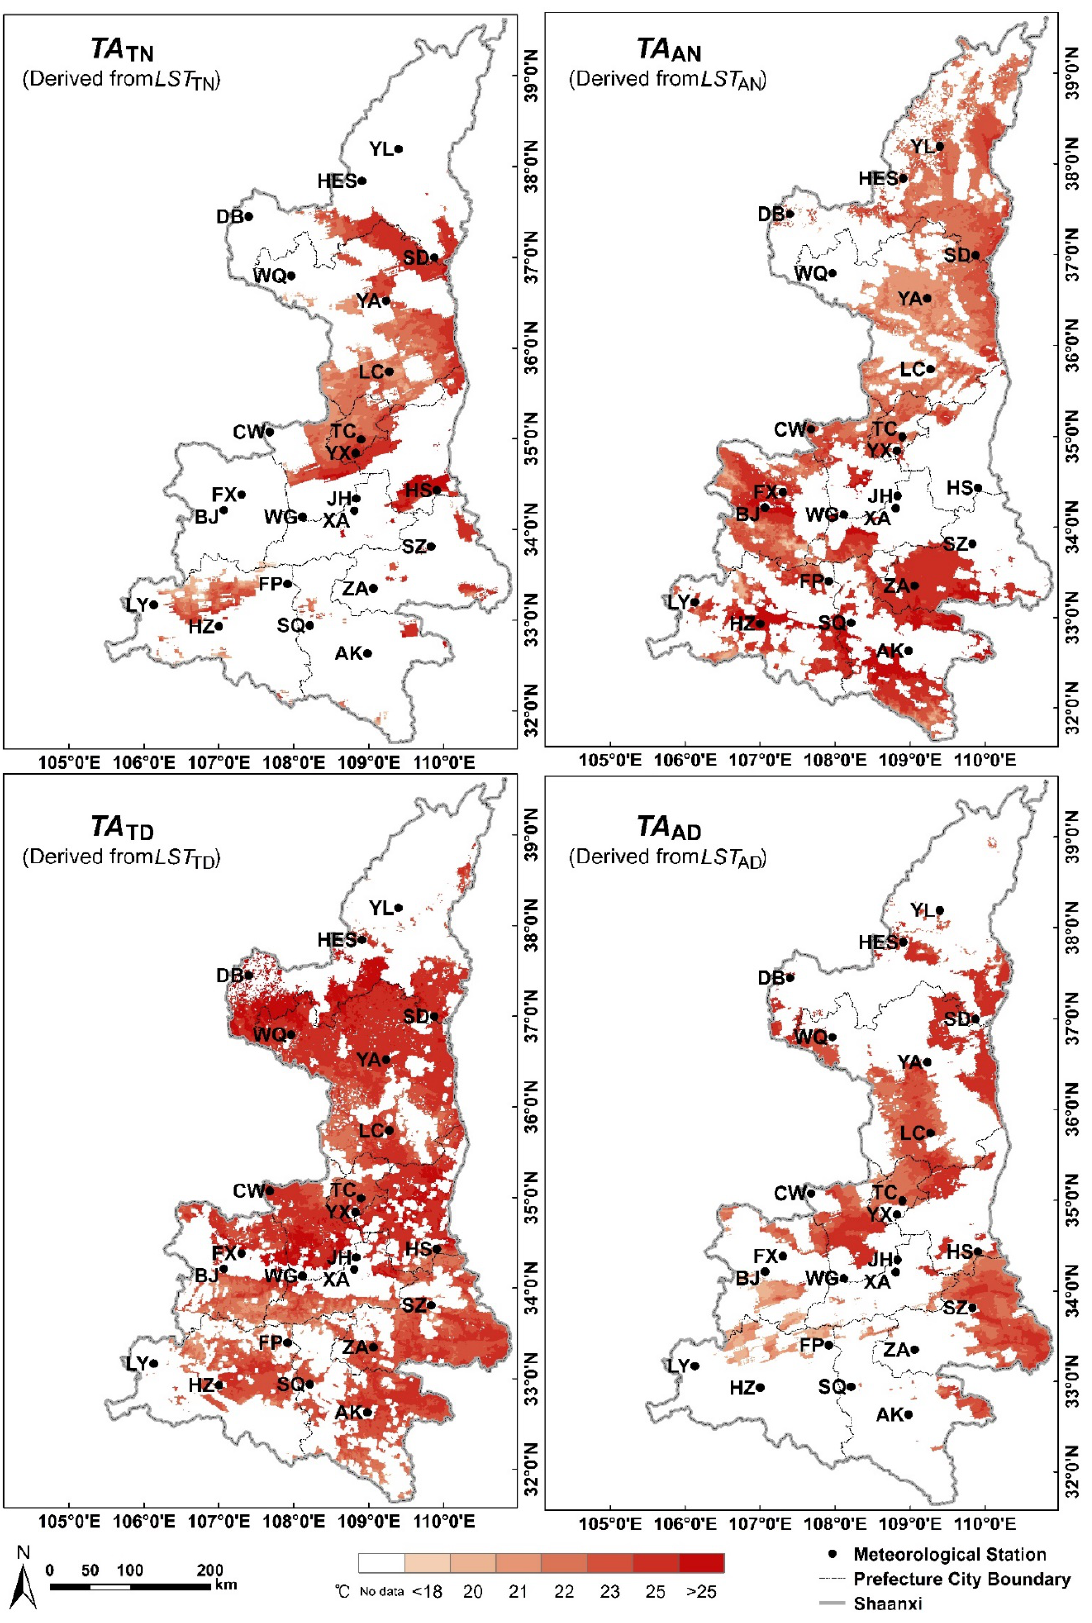
Figure 6. Daily mean air temperature ( TA ) estimated using the daytime and nighttime land surface temperatures (LSTs) from the TERRA and AQUA MODIS products for 21 June